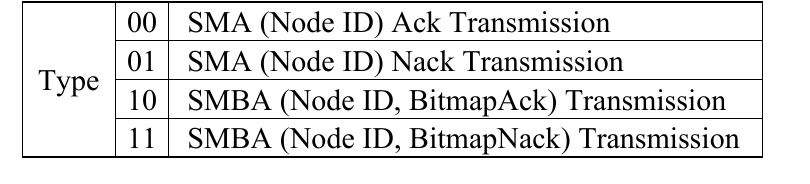
Table 10. Ack Length